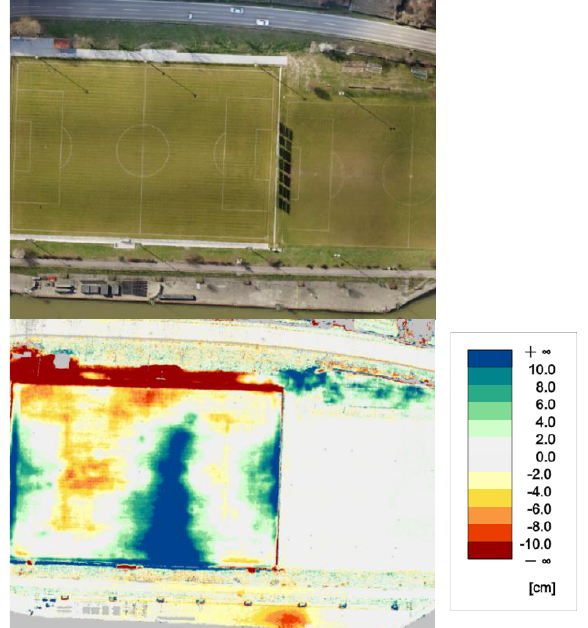
Figure 6. Exemplary elevation differences of LiDAR campaigns 2016 and 2019 ( bottom ) compared to corresponding orthophoto ( top ).